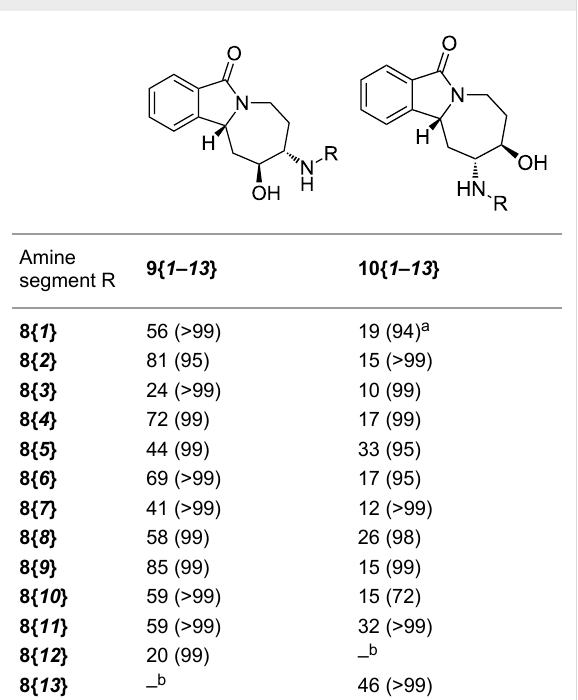
Table 1: Library matrix of products 9{ 1 – 13 } and 10{ 1 – 13 } [isolated yield (%) and purity by ELSD